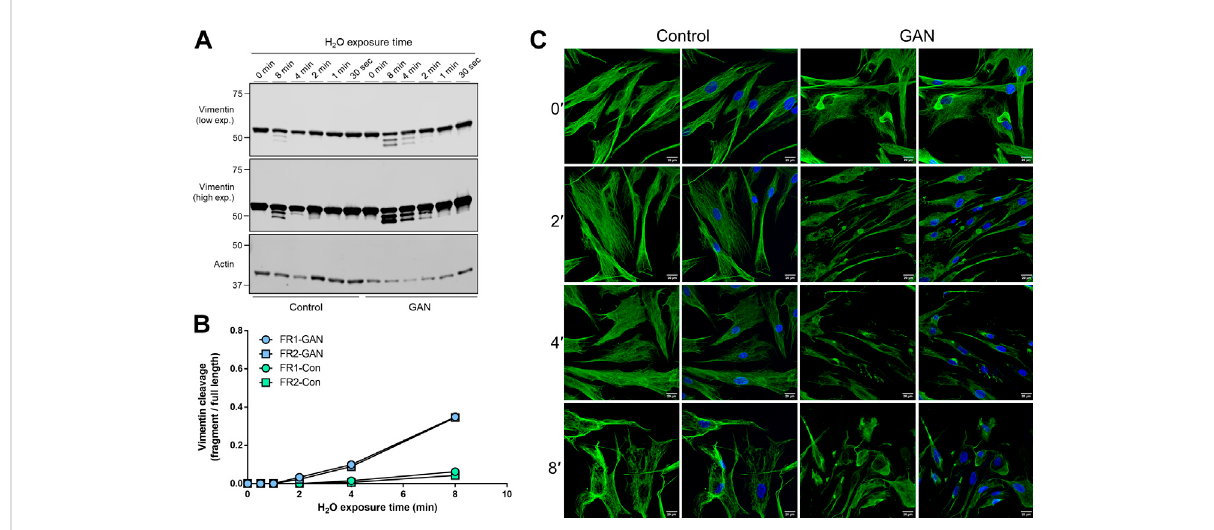
FIGURE 2 Hypotonic stress-induced vimentin cleavage is augmented in GAN compared to control fi broblasts. (A) Immunoblotting of vimentin (top and middle) and actin (bottom; loading control) in reduced Triton X insoluble pellet fractions from control (lanes 1 – 6) and GAN (GAO1B; lanes 7 – 12) fi broblasts exposed to hypotonic stress conditions (sterile molecular grade H – 8 min. Expression of the two vimentin fragments (FR1 and 2 O) for 0 FR2) is increased in GAN patient cells compared to control cells. Low (top) and high (middle) exposure blots of the same membrane are shown for vimentin. (B) Densitometry quanti fi cation of vimentin fragment (FR) intensities relative to full length vimentin in control and GAN fi broblasts exposedto hypotonic stressfor0 – 8 min.Datapoints representvaluesfromasingle experimentand arerepresentativeofatleastthree independent experiments. (C) Immuno fl uorescence analysis ofcontrol 56.3and GAN56.1 fi broblasts stainedwith vimentin(green)and DAPI(blue)after exposure to water for 0 – 8 min; scale bar = 20 μ m. Note signi fi cant breakdown of the vimentin fi lament network in the GAN cells at an earlier timepoint (2 ′ ) compared to the control cells (8 ′